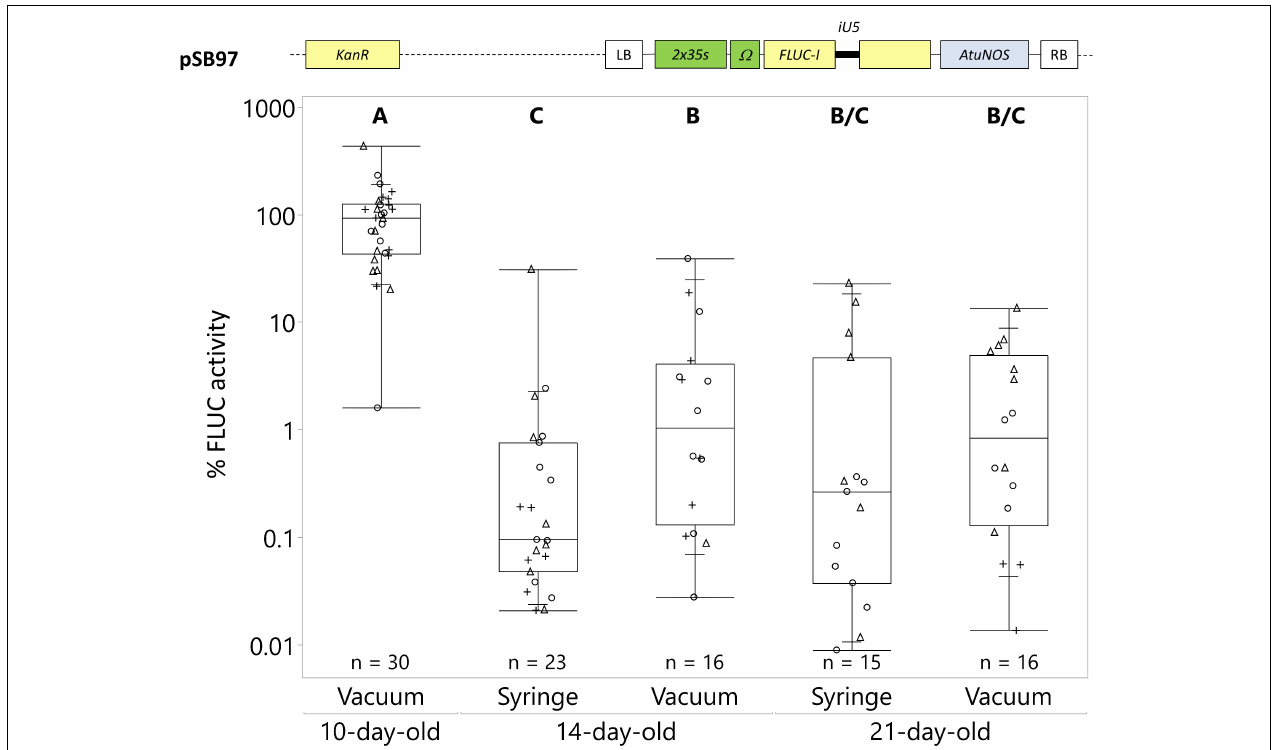
FIGURE 1 | Catharanthus roseus seedling age and infection method significantly affect transient transformation efficiency. C. roseus seedlings at 10, 14, and 21-day-old were infiltrated with A. tumefaciens GV3101 (pMP90) containing the FLUC-I reporter (plasmid pSB97) at OD 600 = 0.2, using either syringe or vacuum infiltration. Samples were taken at 3 dpi. FLUC activity was normalized to protein content. The average FLUC activity to protein content of 10-day-old vacuum infiltrated seedlings was used as reference (set to 100%) to determine the relative FLUC activity of each sample. The experiment was carried out in three independent assays (represented by the + , (cid:13) , (cid:49) symbols). The box plot horizontal line shows the median, ends of the boxes show interquartile range, small marks show the 10th and 90th quantile and whiskers show lowest/highest data point. Different letters indicate values that are significantly different (Tukey-Kramer HSD test on log-transformed data, p <